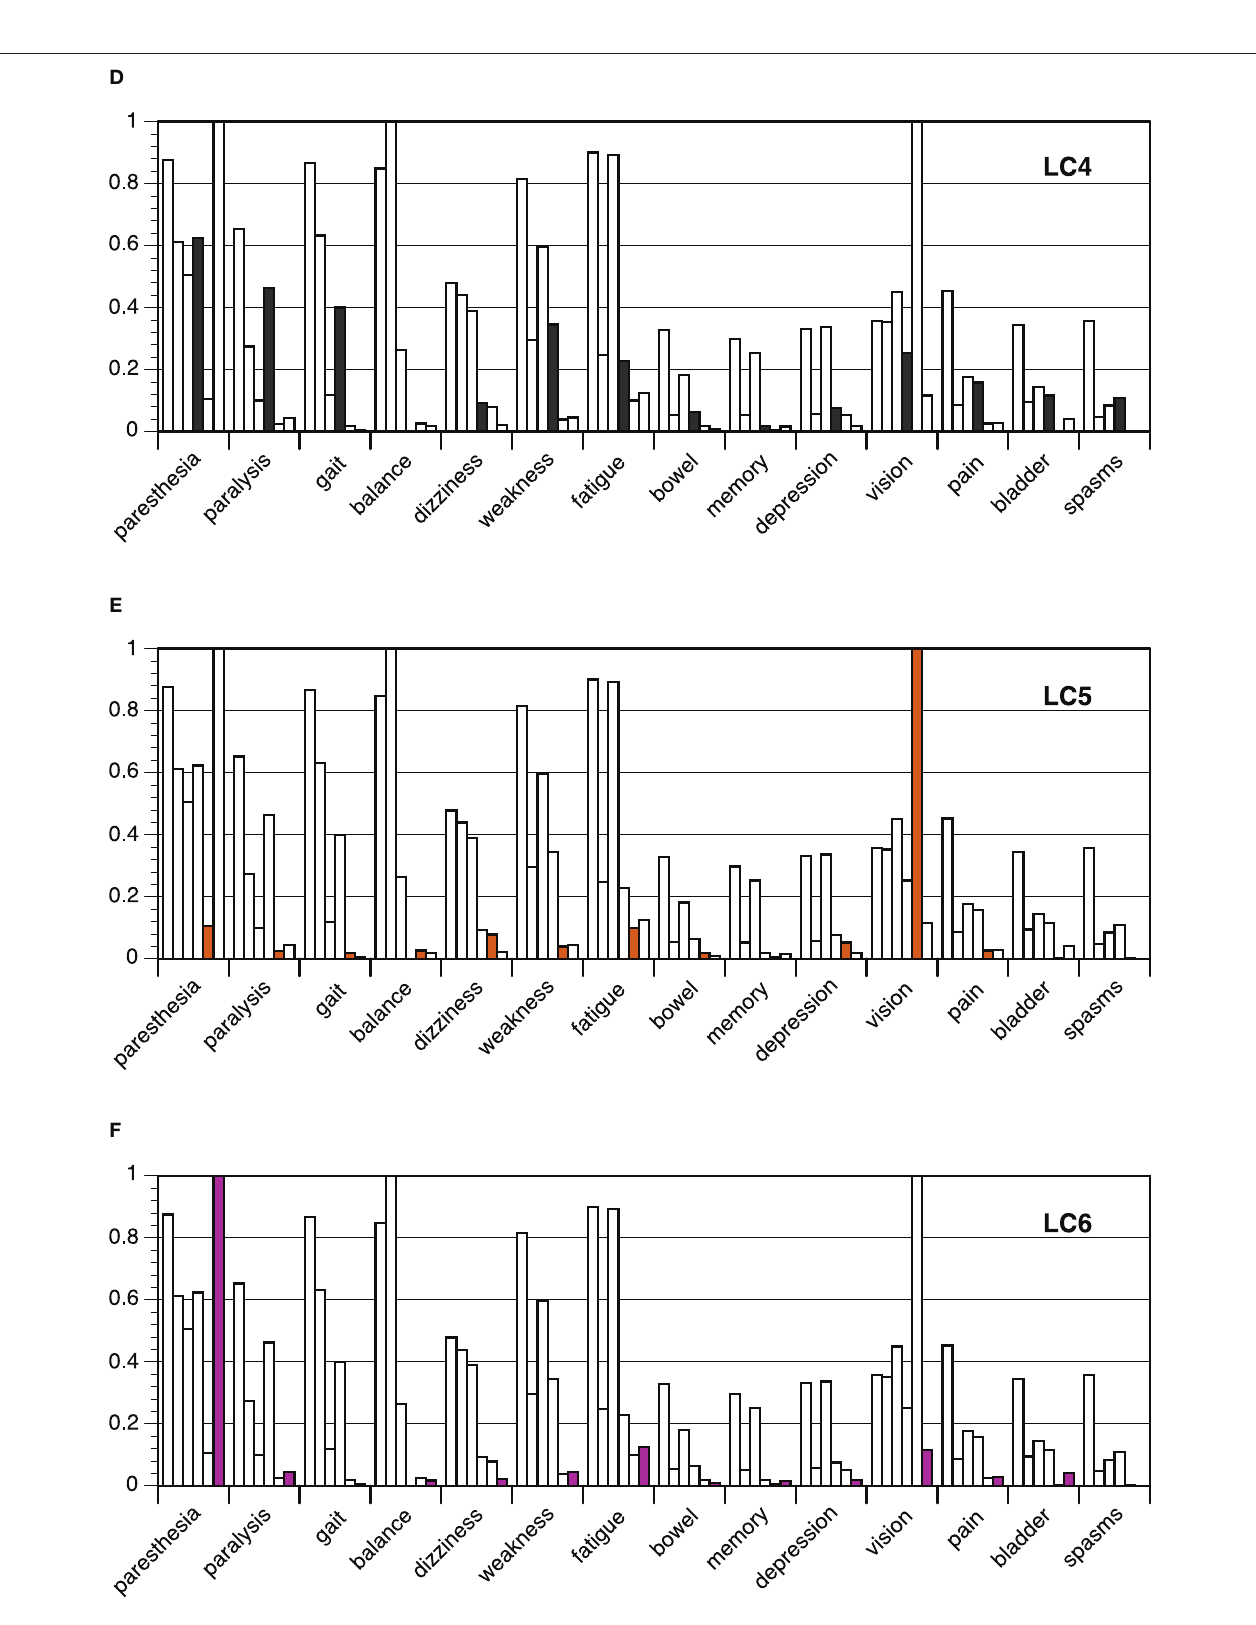
FIGURE 1 | (A–F) : Latent class analysis of onset symptoms in multiple sclerosis: probabilities of onset symptoms per class 1–6.